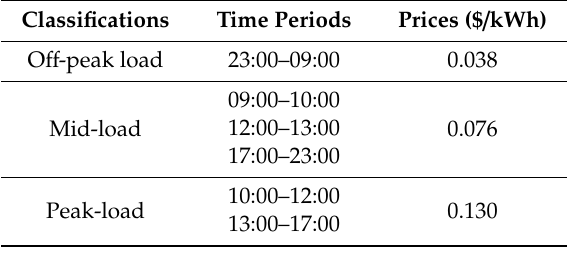
Table 4. Three-level time-of-use (TOU) rates on utility power.